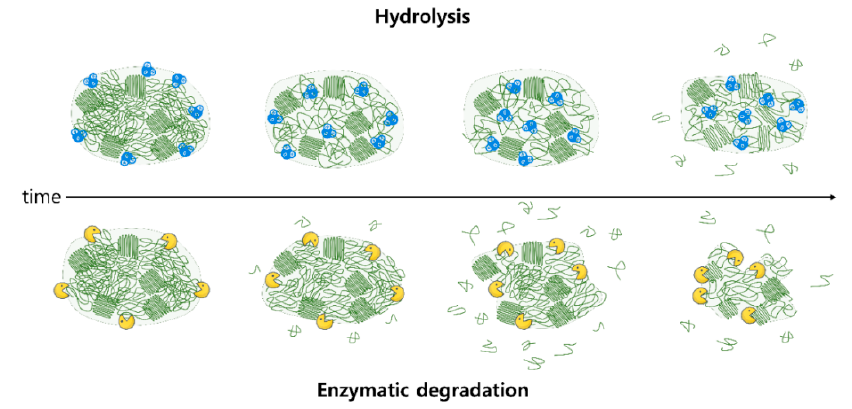
Figure 3. Cartoon representing hydrolysis and enzymatic degradation process as a function of the incubation time for aliphatic polyesters.